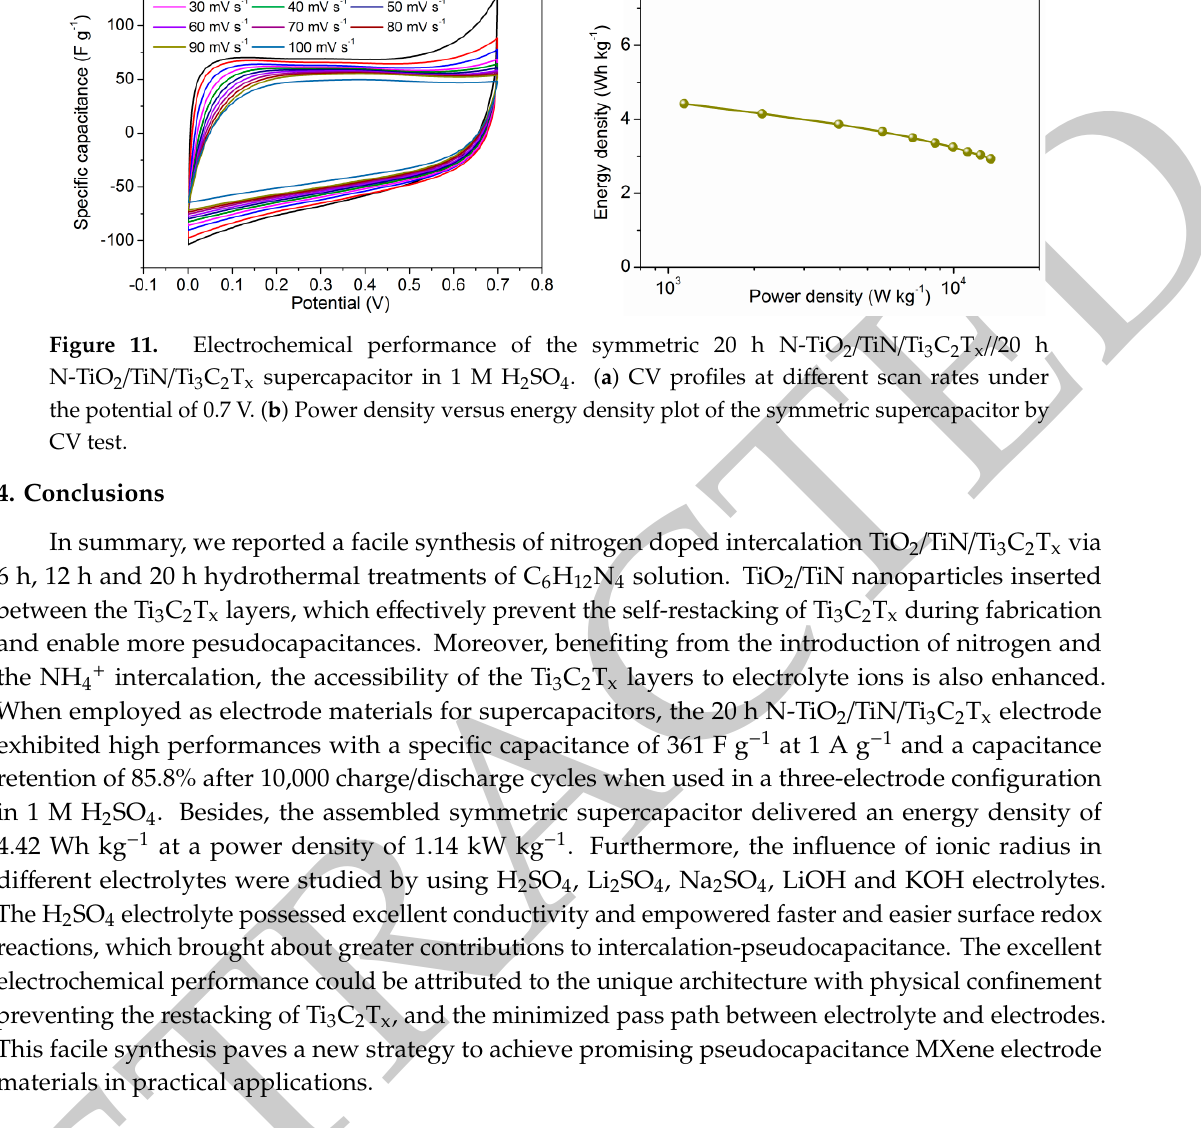
images of pristine Ti 3 AlC 2 , Figure S3: CV curves at scan rate of 50 mV s − 1 of conductive carbon paper, Figure S4: CV and GCD curves of Ti 3 C 2 T x in di ff erent electrolytes of (a,b) Na 2 SO 4 , (c,d) Li 2 SO 4 , (e,f) KOH and (g,h) LiOH, Figure S5: CV and GCD curves of 20 h N-TiO 2 / TiN / Ti 3 C 2 T x in di ff erent electrolytes of (a,b) Na 2 SO 4 , (c,d) Li 2 SO 4 , (e,f) KOH and (g,h) LiOH, Figure S6: CV and GCD curves of (a,b) 6 h, (c,d) 12 h N-TiO 2 / TiN / Ti 3 C 2 T x in H 2 SO 4 electrolyte, Figure S7: Nyquist plots of 20 h N-TiO 2 / TiN / Ti 3 C 2 T x in di ff erent electrolytes. 1 M H 2 SO 4 have lower resistance of the bulk electrolyte solution compared with Na 2 SO 4 , Li 2 SO 4 , KOH and LiOH, Figure S8: GCD plots at di ff erent current densities of the symmetric 20 h N-TiO 2 / TiN / Ti 3 C 2 T x // 20 h N-TiO 2 / TiN / Ti 3 C 2 T x supercapacitor in 1 M H 2 SO 4